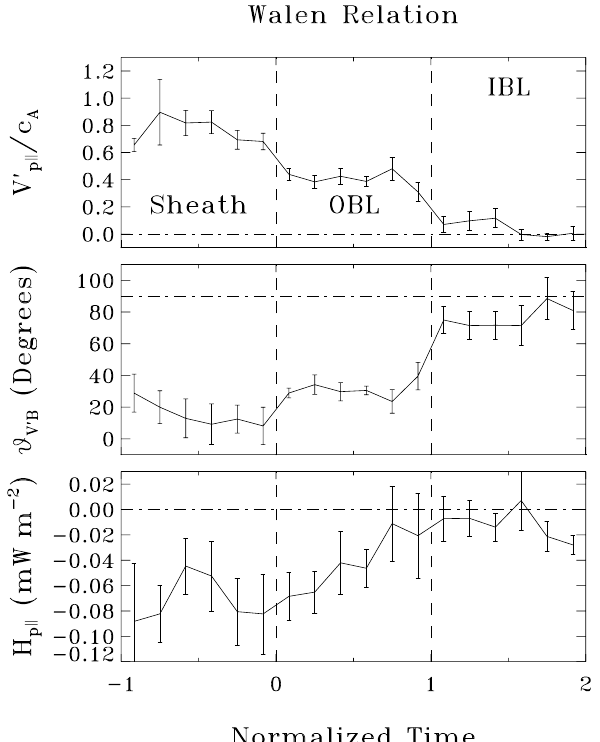
/c A , of the field- k , parallel to B k